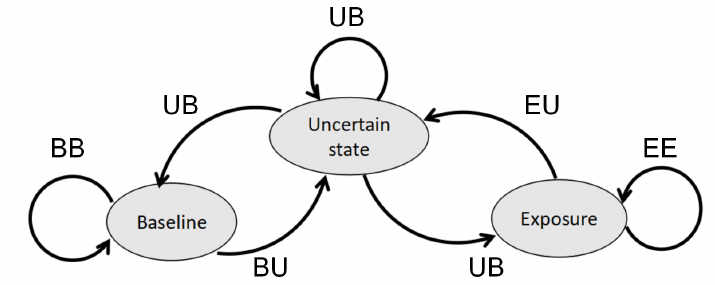
Figure 4. The state machine of a gas-sensing process. The transition conditions are explained further in the